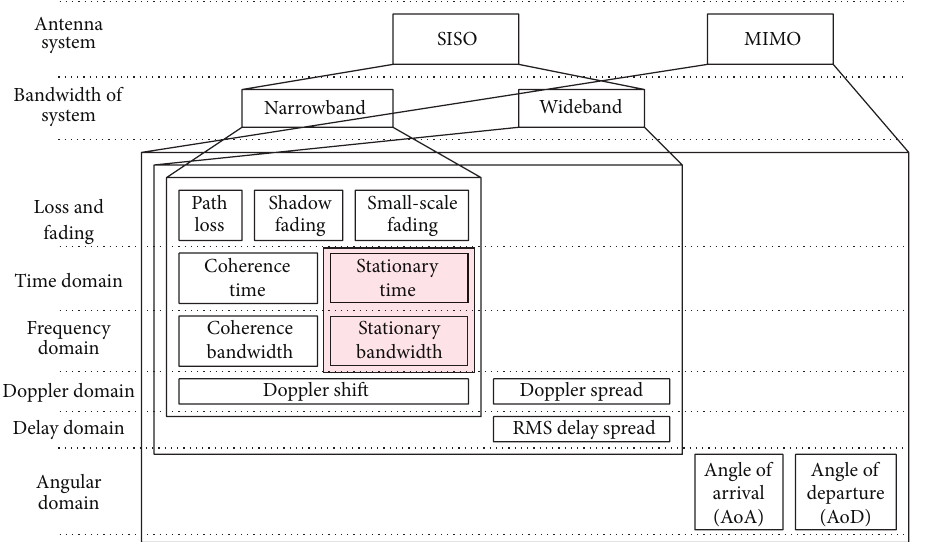
Figure 3: Panorama of metrics for WSV2X channel classified in accordance with the antenna configuration and bandwidth of the system and different domains. Stationary time and stationary bandwidth (in the block with light red color) are the two specific parameters in the nonstationary channel.